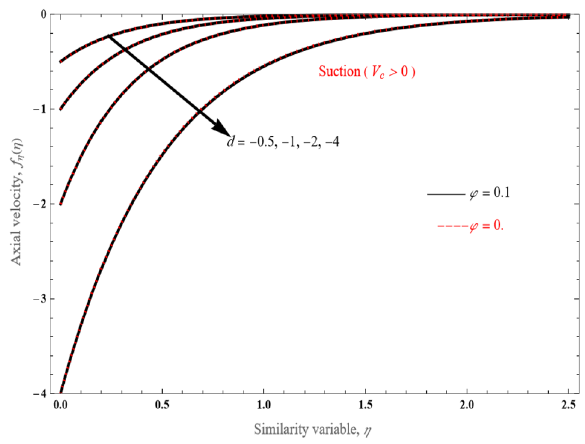
Figure 5. The axial velocity profiles for the algebraically decaying solutions for various values of d .